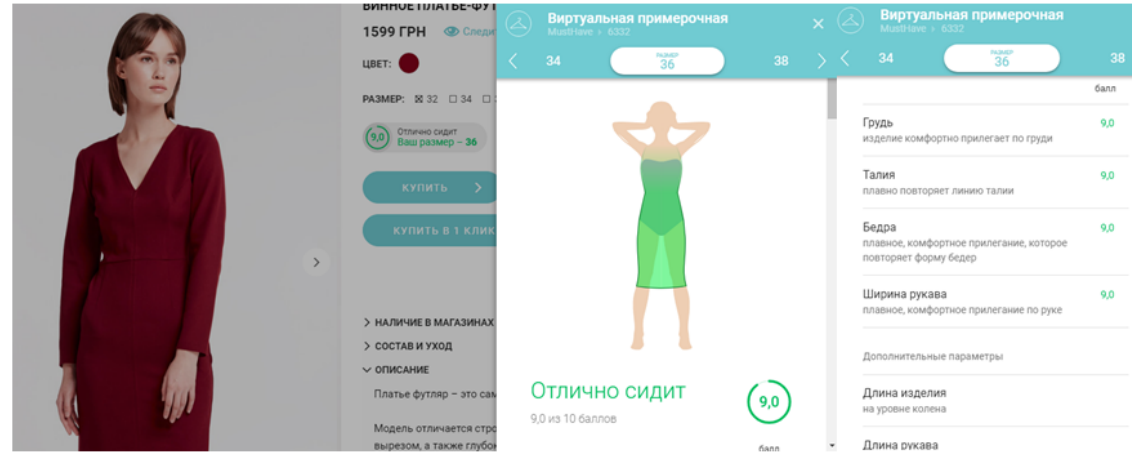
Figure 3. The result of the virtual fitting with the use of the Astrafit